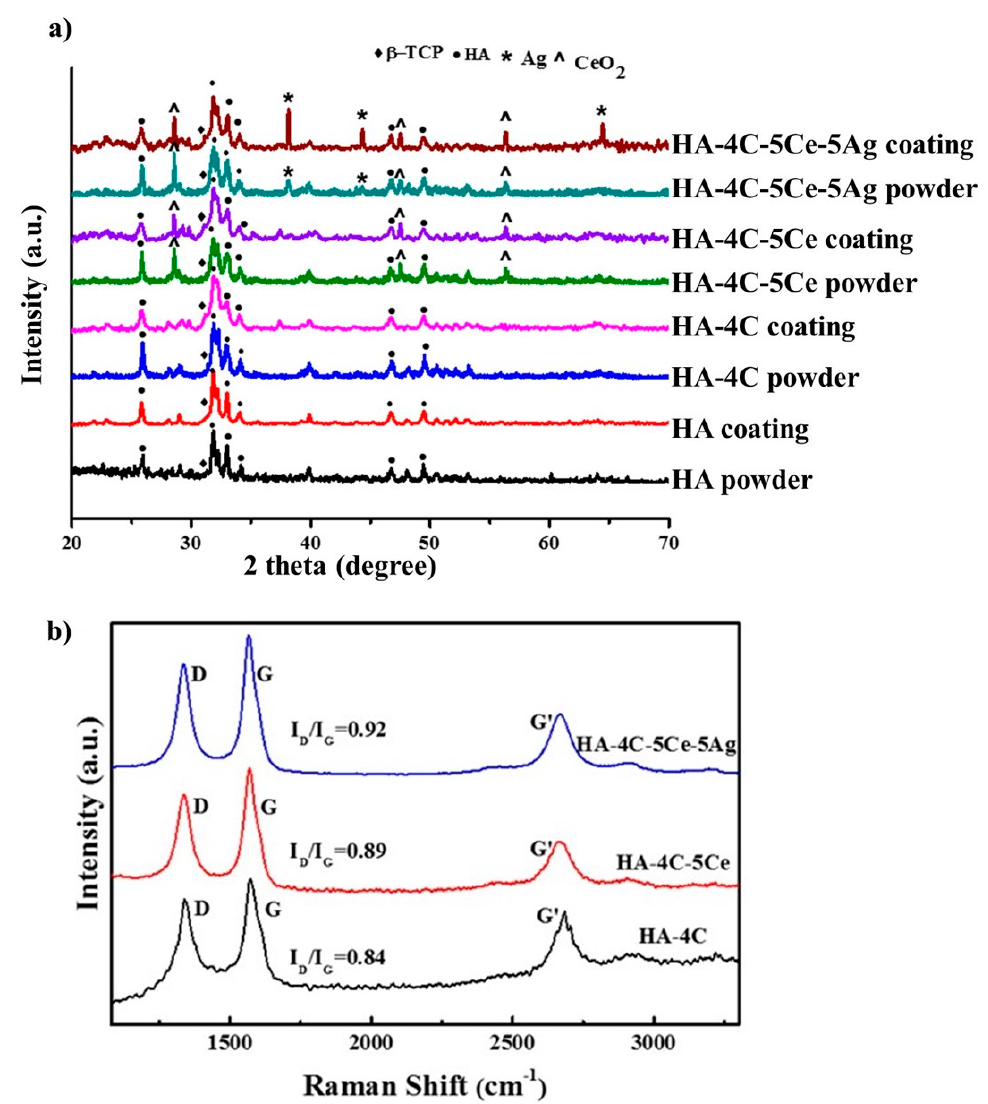
Figure 1. ( a ) X-ray diffraction (XRD) pattern of powders and coatings of hydroxyapatite (HA), HA-4C, HA-4C-5Ce, and HA-4C-5Ce-5Ag on TiAl6V4 substrate and ( b ) Raman spectra of carbon nanotube (CNT) containing composite